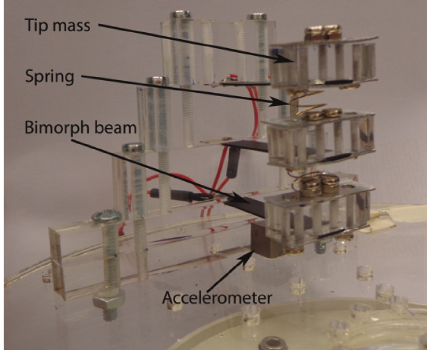
Figure 12: Experimental bimorph